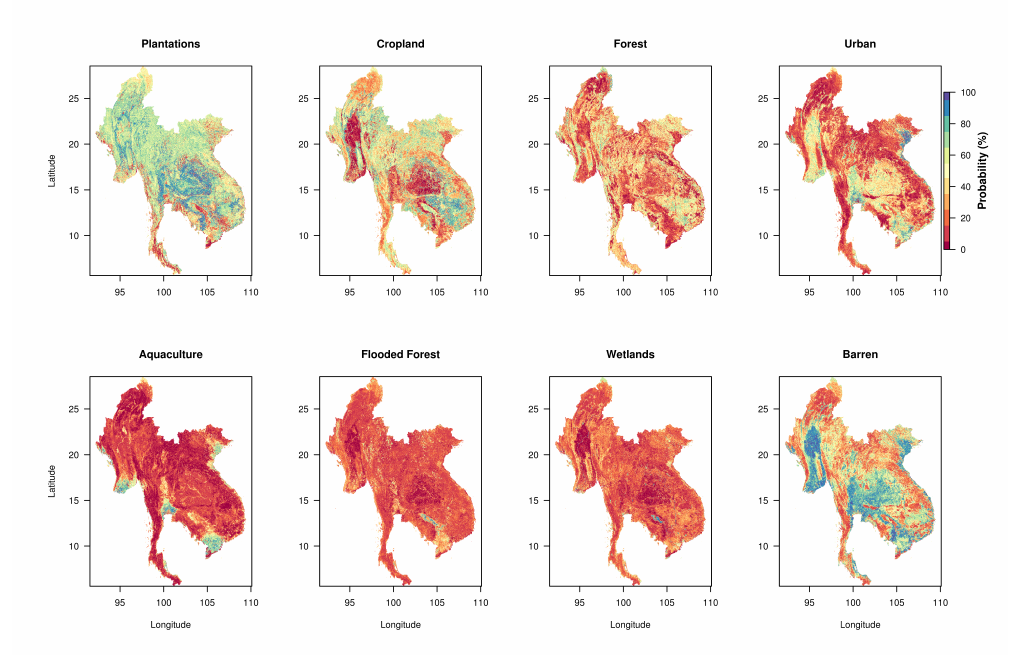
Figure 7. Probability change maps for ‘Generic to specific’ category for the different land cover types.